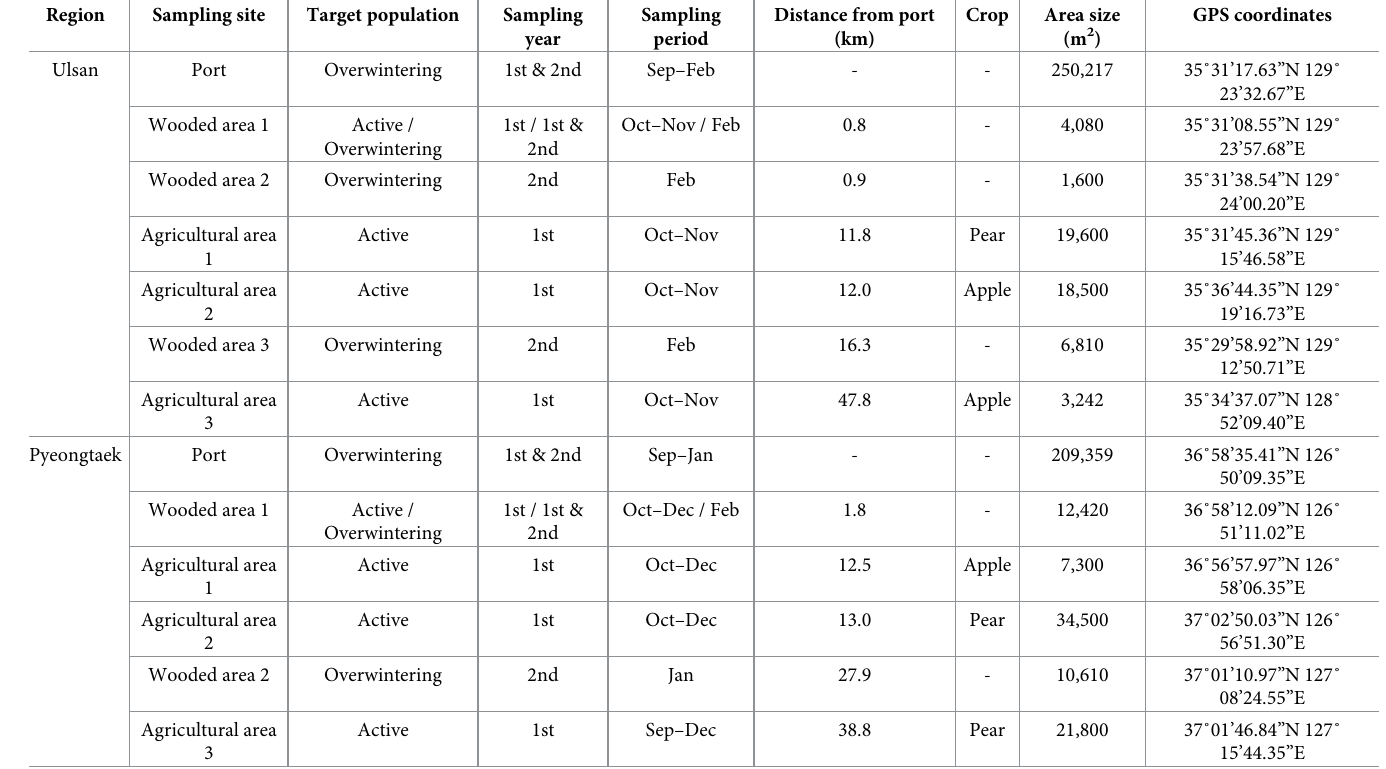
Table 1. Information of sampling sites for surveying active and overwintering Halyomorpha halys populations in Ulsan and Pyeongtaek regions. Region Sampling